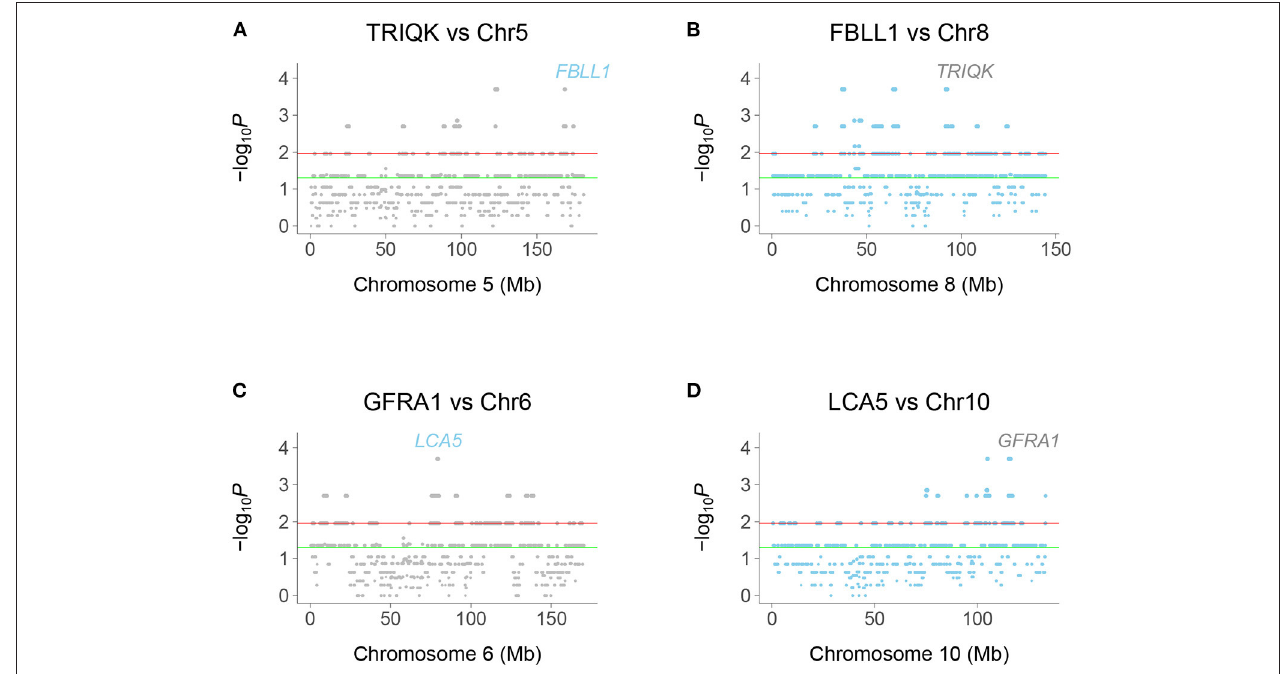
FIGURE 2 | Chromosome plots of human genetic interactions. (A) Co-inheritance of peak window at TRIQK and windows on Chromosome 5, with FBLL1 exceeding significance thresholds. (B) Co-inheritance of FBLL1 and windows on Chromosome 8, with TRIQK exceeding significance thresholds. (C) Co-inheritance of GFRA1 and windows on Chromosome 6, with LCA5 exceeding significance thresholds. (D) Co-inheritance of LCA5 and windows on Chromosome 10, with GFRA1 exceeding significance thresholds. Green horizontal line, P = 0.05, Red horizontal line, FDR =